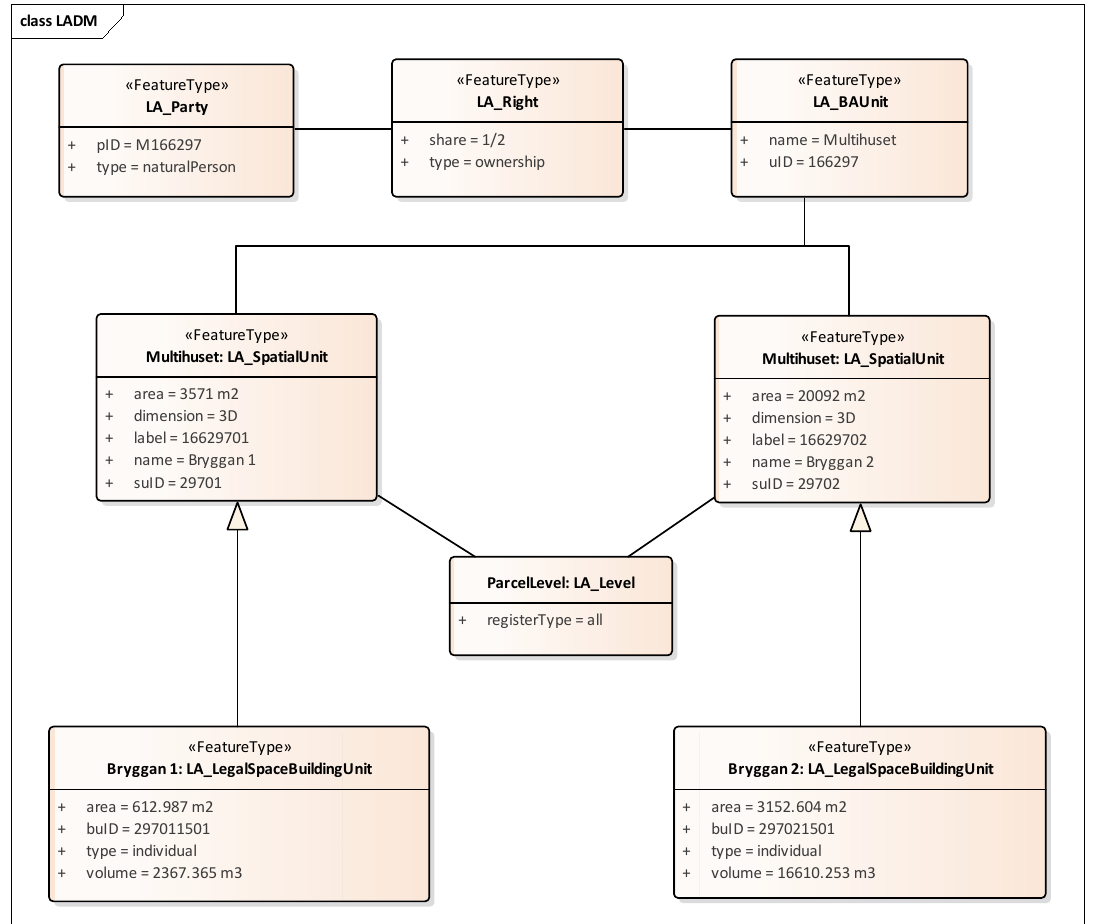
Figure 9. LADM UML and the associated relationships between the classes.